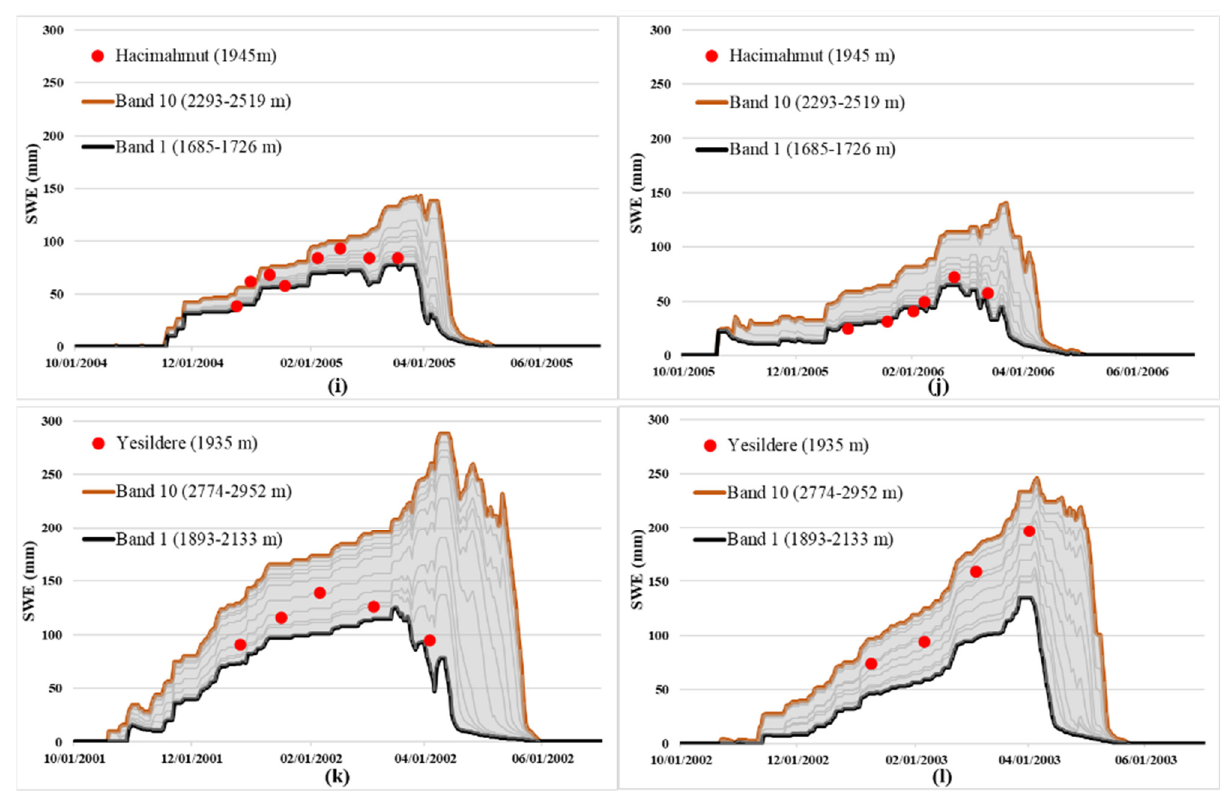
Figure 8. SWE comparison charts between SWAT elevation bands and snow stations for Dogangun in ( a ) 2002 and ( b ) 2003, Eleskirt in ( c ) 2007 and ( d ) 2010, Haciomer in ( e ) 2003 and ( f ) 2007, Guzelyayla in ( g ) 2002 and ( h ) 2003, Hacimahmut in ( i ) 2005 and ( j ) 2006, Yesildere in ( k ) 2002 and ( l ) 2003 hydrological year.